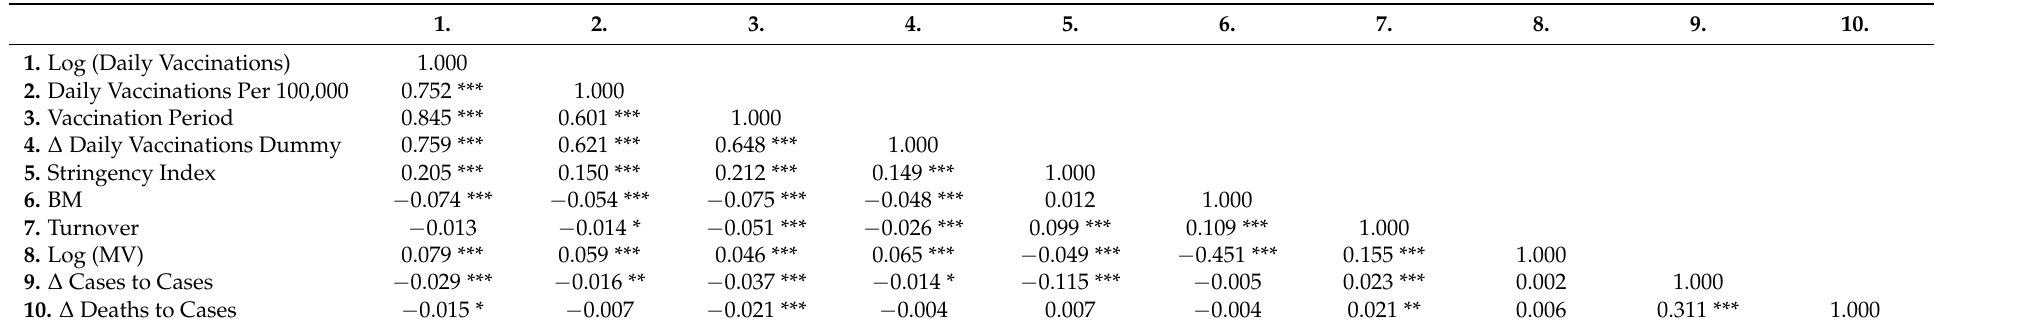
Table 3. Pairwise correlation coefficients between major